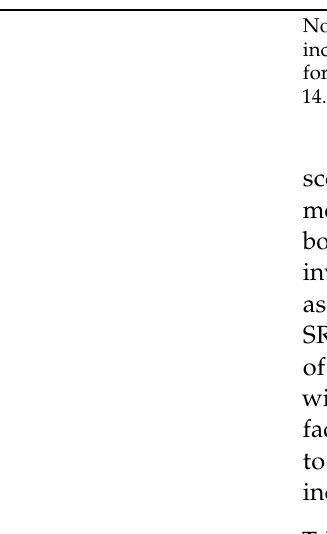
Table 2. Tests of measurement invariance in the PsyCap Scale between